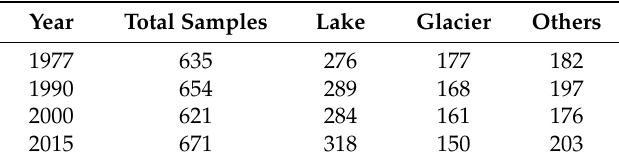
Table 1. Detail information of reference